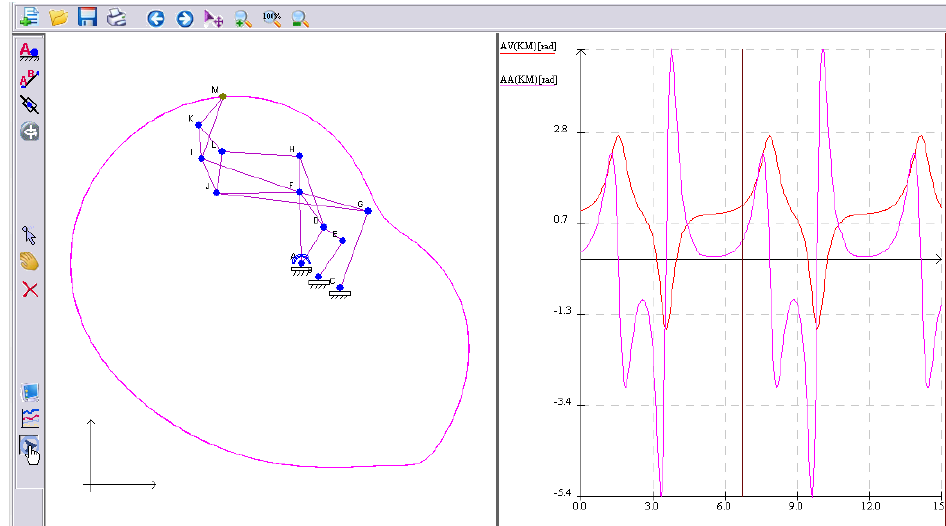
Figure 11. Simulation of a mechanical arm, together with its kinematic